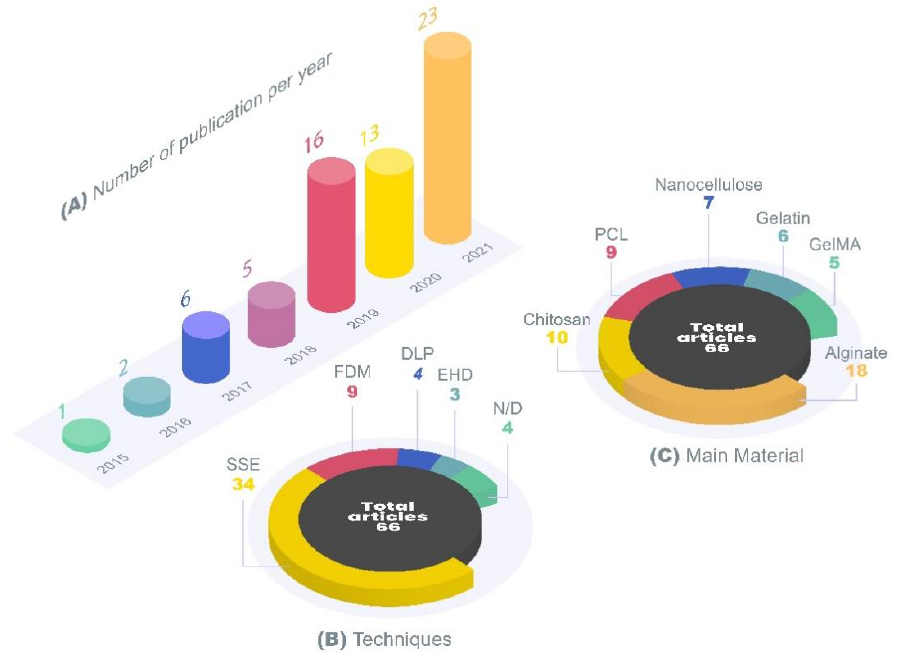
Figure 3. Main characteristics of the studies included in this review: ( A ) number of publications per year using 3D printing for topical skin applications; ( B ) number of records of the most em- ployed 3D printing techniques; ( C ) number of records of the most employed materials; DLP, digital light processing; EHD, electrohydrodynamic jet; FDM, fused deposition modeling; GelMA, gelatin- methacryloyl; N/D, not clearly defined (according to the description described by the authors, it was not possible to categorize it in this review); PCL, polycaprolactone; SSE, semisolid